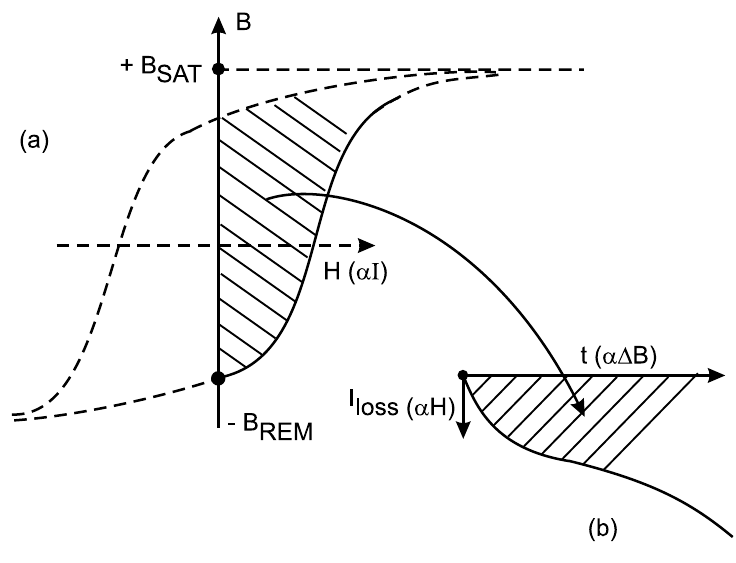
FIG. 25. (a) Schematic B - H loop, showing (full line) trajectory swept out during main pulse; (b) under constant voltage ( dB=dt ), loss current waveform is a rotation of B - H